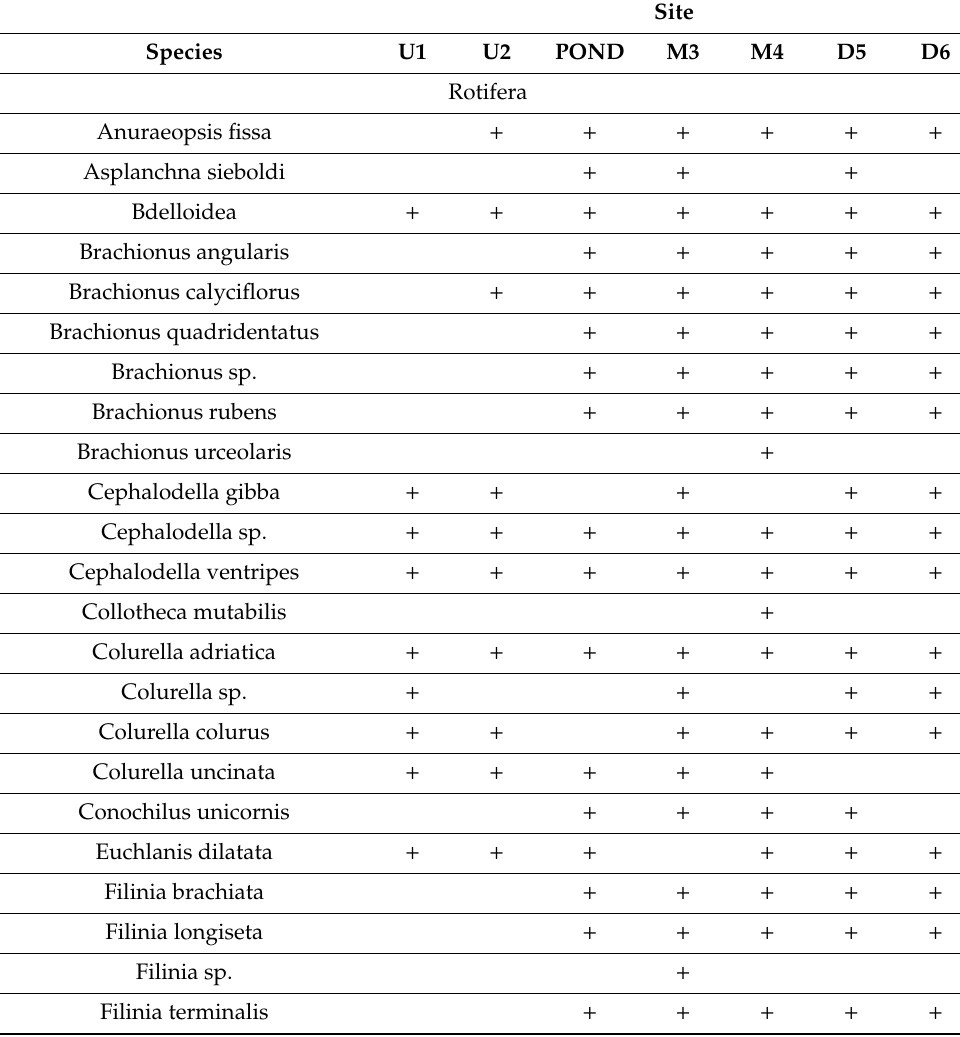
Figure 3. Jaccard taxonomical similarity between sites in the Bukówka stream. Table 2. Taxonomic composition of zooplankton observed at sites of the Bukówka stream.